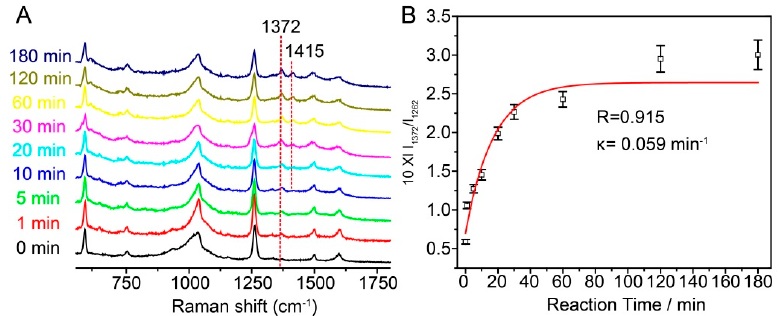
Figure 3. ( A ) SERS spectra of AuNPs/OPD solution in the presence of Cu 2+ at different reaction times under incubation at 37 °C; ( B ) Plot of 10 × I 1372 /I 1262 against different reaction times.